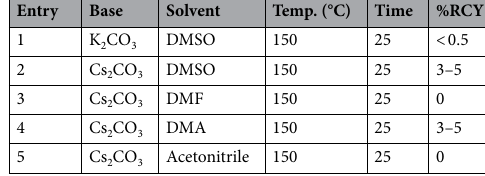
Table 1. Optimization of the conditions for the [ 18 F]-incorporation into the TFMO moiety.